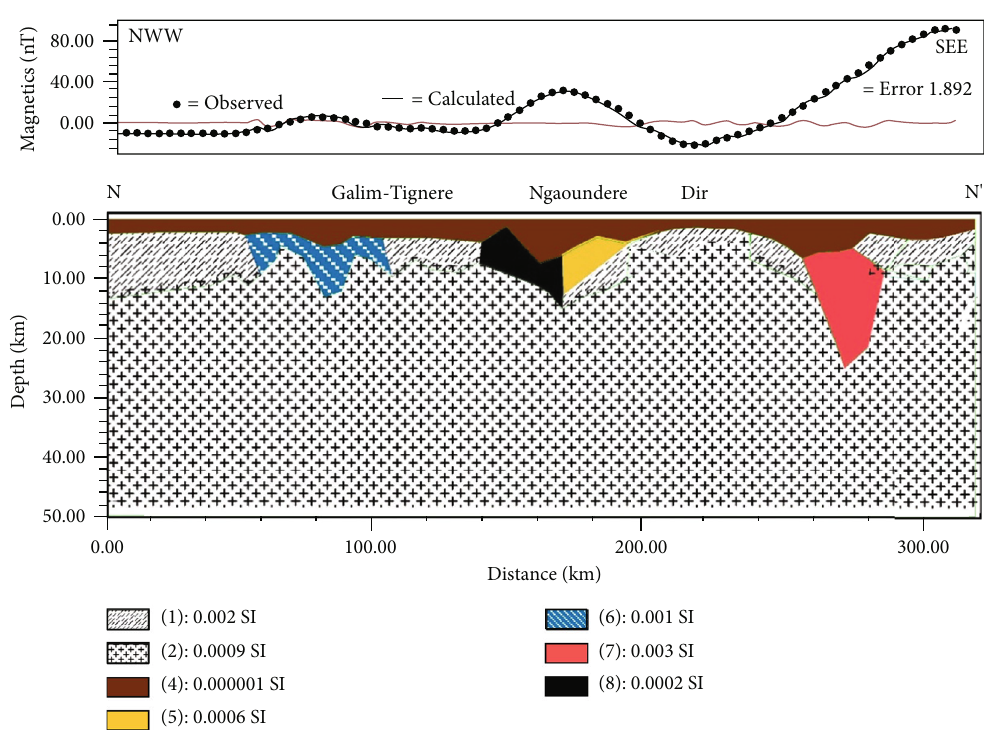
Figure 10: 2D magnetic modeling along N-N ′ pro fi le in WNW-ESE